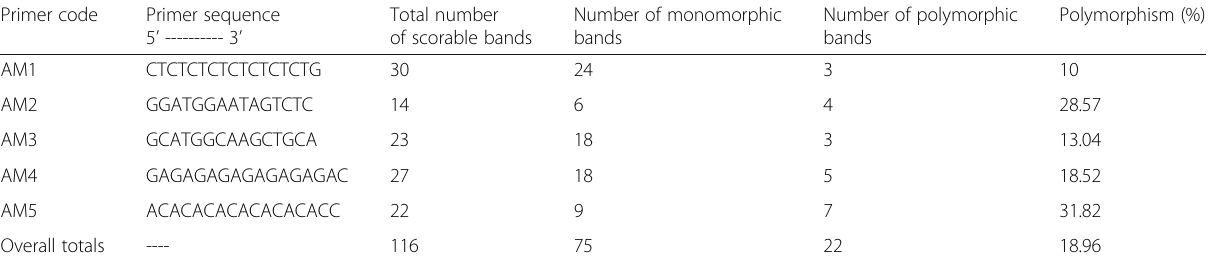
Table 5 ISSR-PCR amplification products of DNA extracted from different samples of J. curcas plants using different five ISSR primers